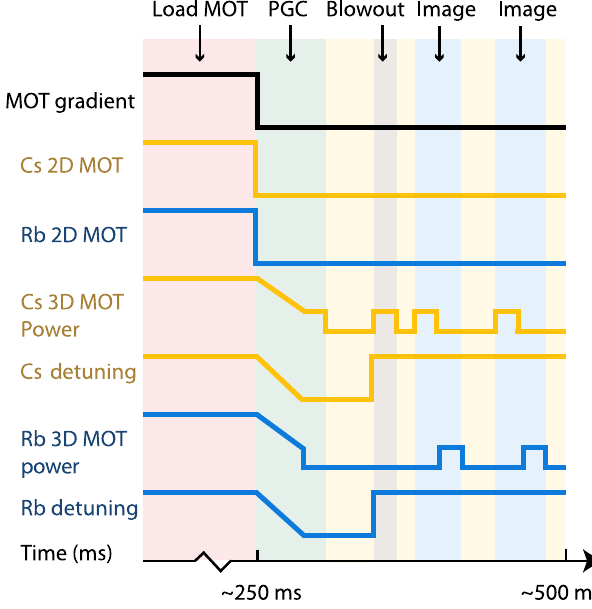
FIG. 6. Experimental sequence. Diagram of the experimental sequence. Cs (Rb) 2D MOT refers to the state (on or off) of the Cs (Rb) 2D MOT cooling beams. We first load a dual-element MOT for approximately 250 ms. After MOT formation, the 2D MOT beams are turned off, and the 3D MOT beam powers and detunings are ramped to perform polarization-gradient cooling.